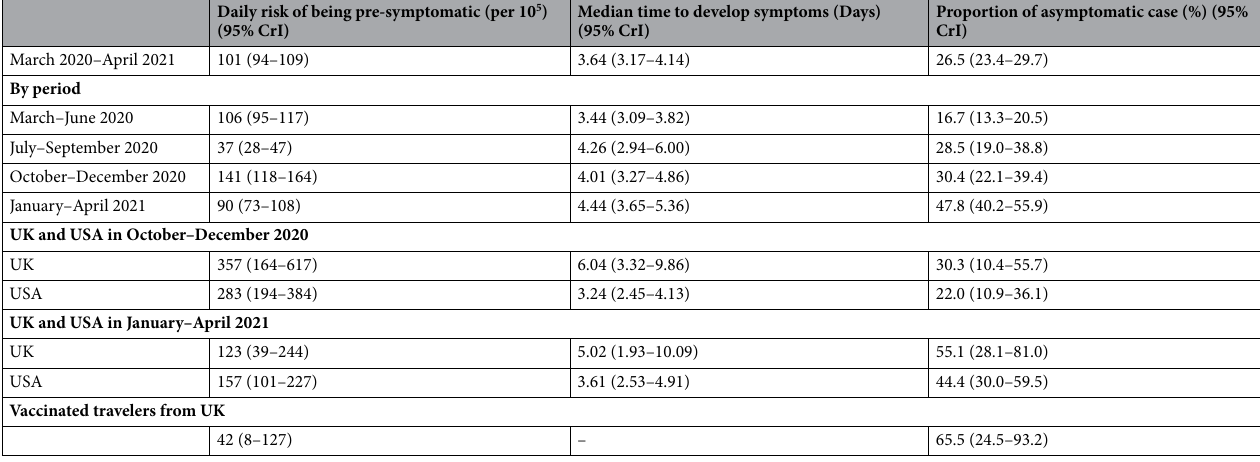
Table 1. The estimated daily rate of being pre-symptomatic and asymptomatic, and progression from pre- symptomatic to symptomatic COVID-19 among Taiwanese imported cases. Vaccinated travelers from UK: The vaccine efficacy was applied to the scenario in the UK in October–December 2020.